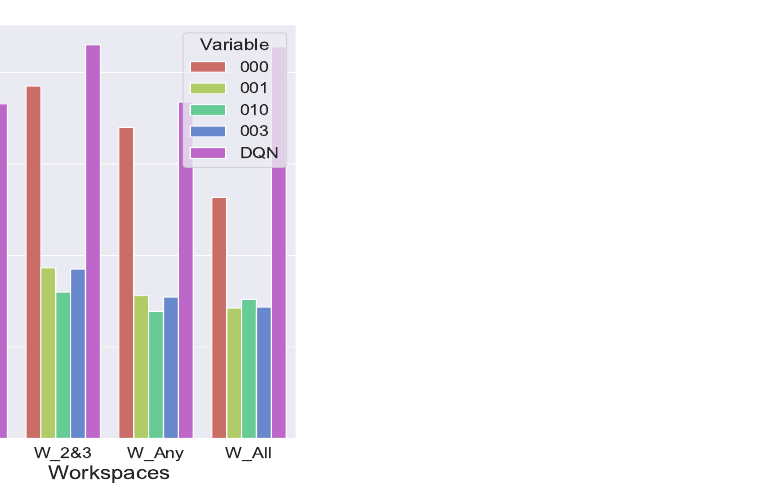
Figure 13. Comparison of perfect daylight hours from the top 4 most frequented combinations by rhe DQN Agent against DQN combinations.